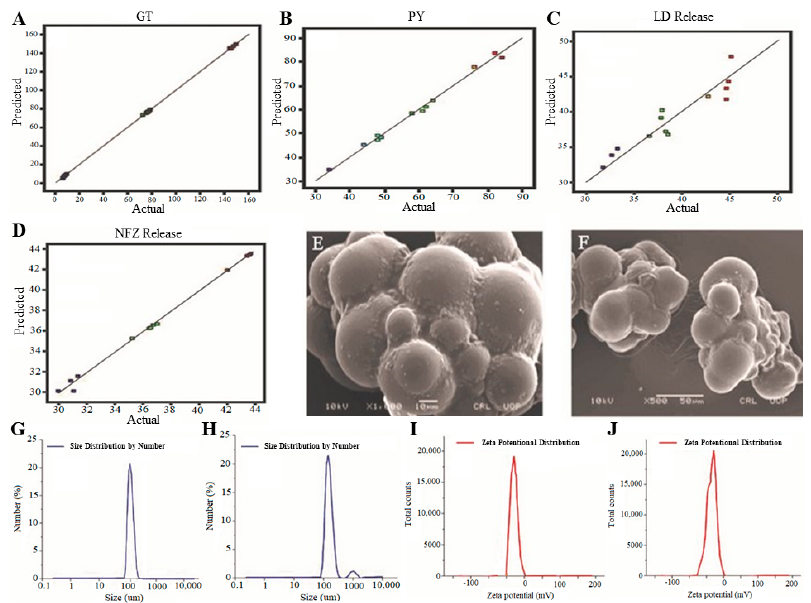
Figure 3. Comparative graphs of predicted versus experimental results of GT ( A ); PY ( B ); LD release ( C ); NFZ release ( D ) SEM microphotographs ( E , F ); zeta size analysis curve ( G , H ); and zeta potential curve ( I , J ); of drug-unloaded and drug-loaded optimized silica microspheres. Table 2. Composition of optimized formulation with experimental values of prediction error, desirability factor, microsphere size, zeta potential, PY, GT, NFZ and LD release.